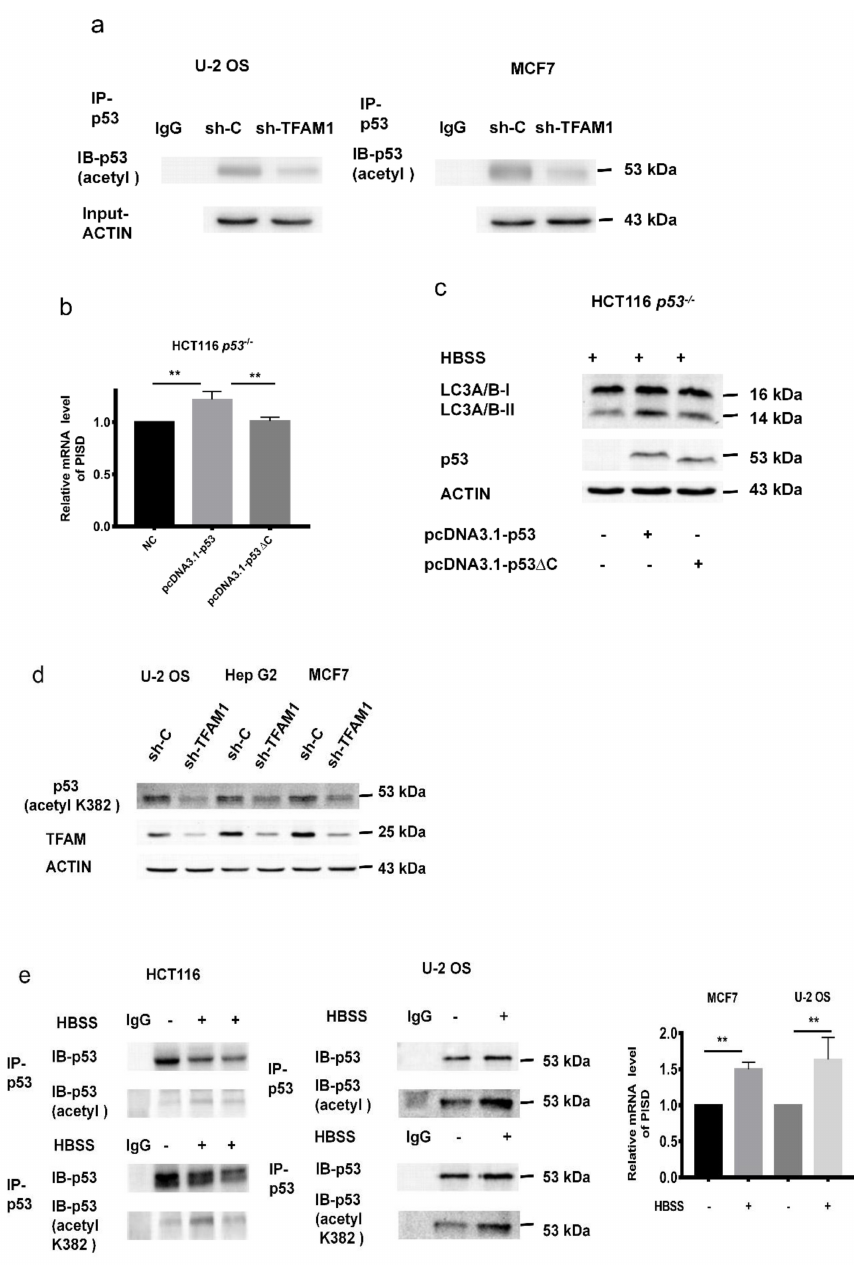
Figure 5. C-terminal region acetylation of p53 regulates PISD expression. ( a ) Analysis of the acetylation of p53 in TFAM knockdown MCF7 and U-2 OS cells after treatment with HBSS for six hours. ( b ) Under HBSS treatment, the mRNA levels of PISD in HCT116 p53 - / - cells after being transfected with the pcDNA3.1-p53 or pcDNA3.1-p53 ∆ C construct. ( c ) Under HBSS treatment, the protein level of LC3-II in HCT116 p53 - / - cells after being transfected with the pcDNA3.1-p53 or pcDNA3.1-p53 ∆ C construct. ( d ) The levels of acetylated p53 (K382) in TFAM knockdown cells. ( e ) After treatment with HBSS for six hours, immunoprecipitation and immunoblotting analysis of the acetylation levels of p53 and qRT-PCR analysis of PISD mRNA levels in U-2 OS and HCT116 cells. Each independent experiment was repeated three times or more, and data are presented as the mean ± SD. ** p <